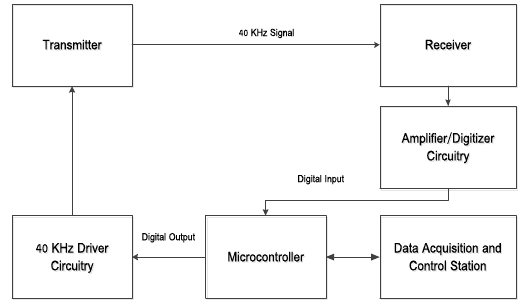
Figure 6. 3D positioning system schematic.